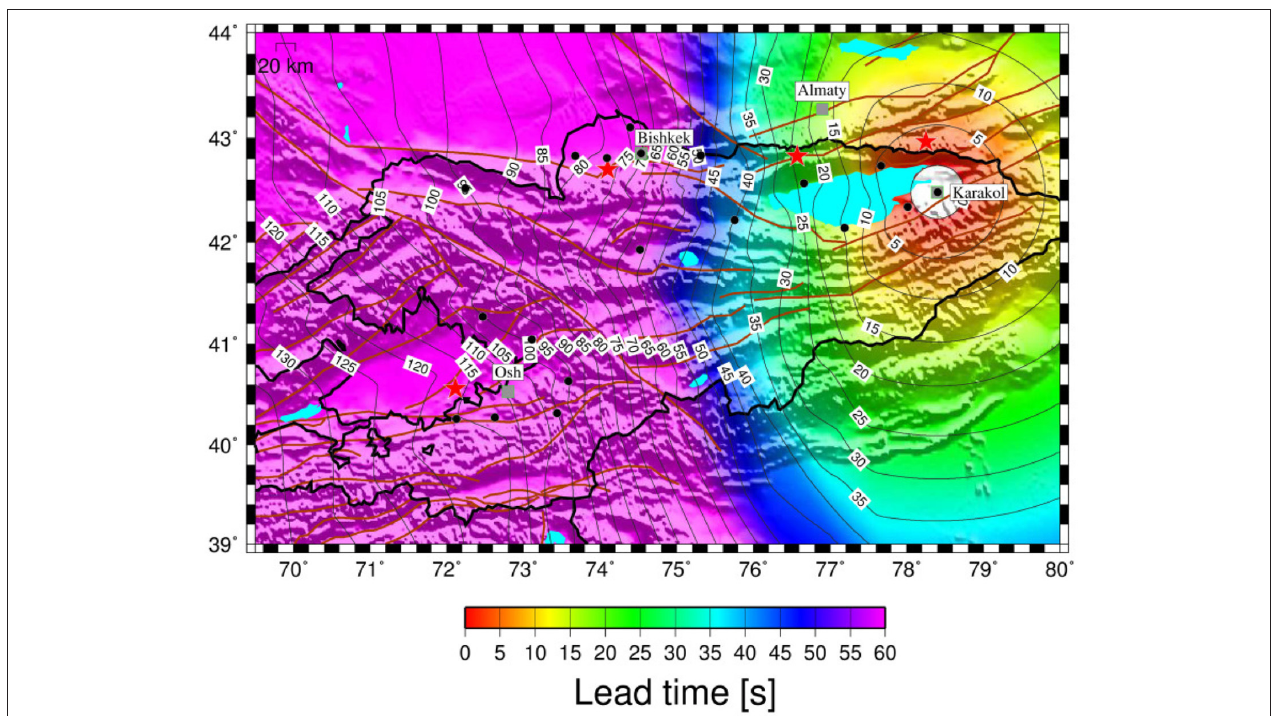
FIGURE 8 | The lead-times for Karakol, using a combined regional and on-site approach, as a function of the location of possible seismic events (i.e., a 0.1 by 0.1 ◦ grid). Also shown are the main cities (gray squares) and a selection of historical or hypothetical earthquakes (red stars, see Figure 1 and text for explanation). The brown lines indicate the main tectonic alignments and faults existing in the